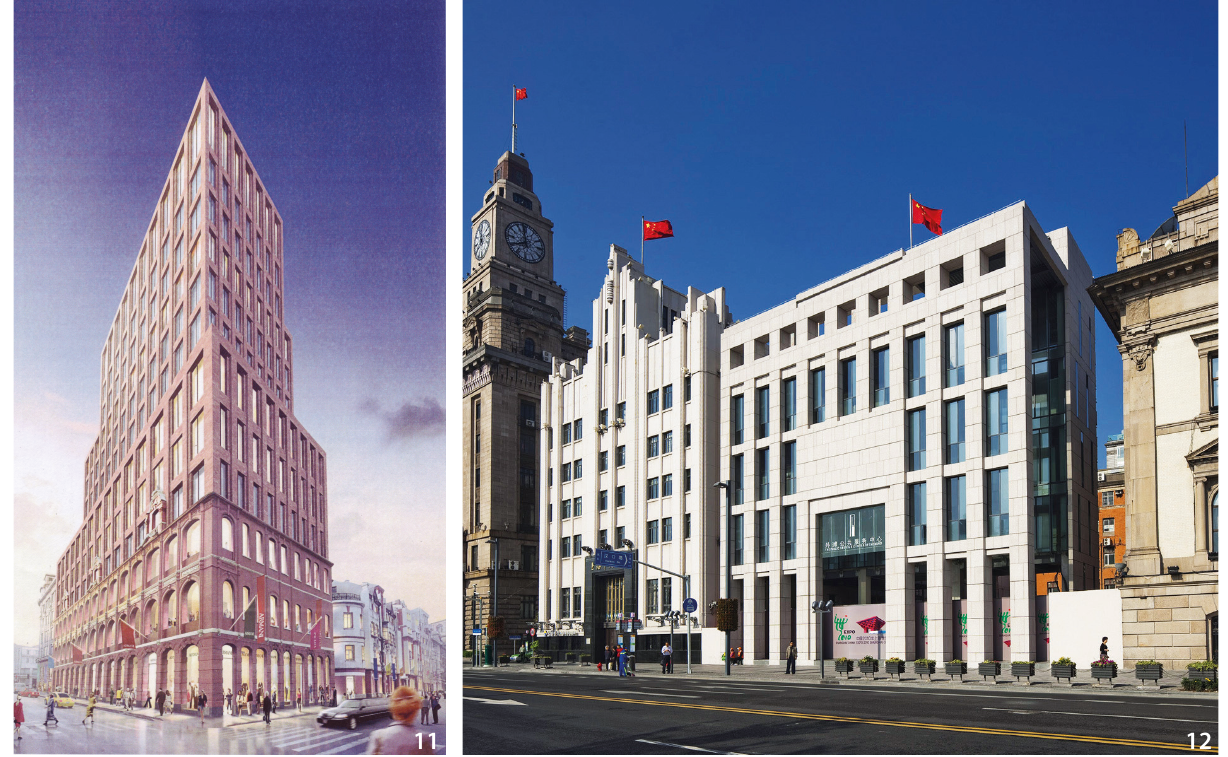
Figure 11 The extension of the former Andrew & George Building (Source: David Chipperfield Architects). Figure 12 Shanghai Public Service Centre on the Bund (Source: Institute of Shanghai Architectural Design and Research Co., Ltd).